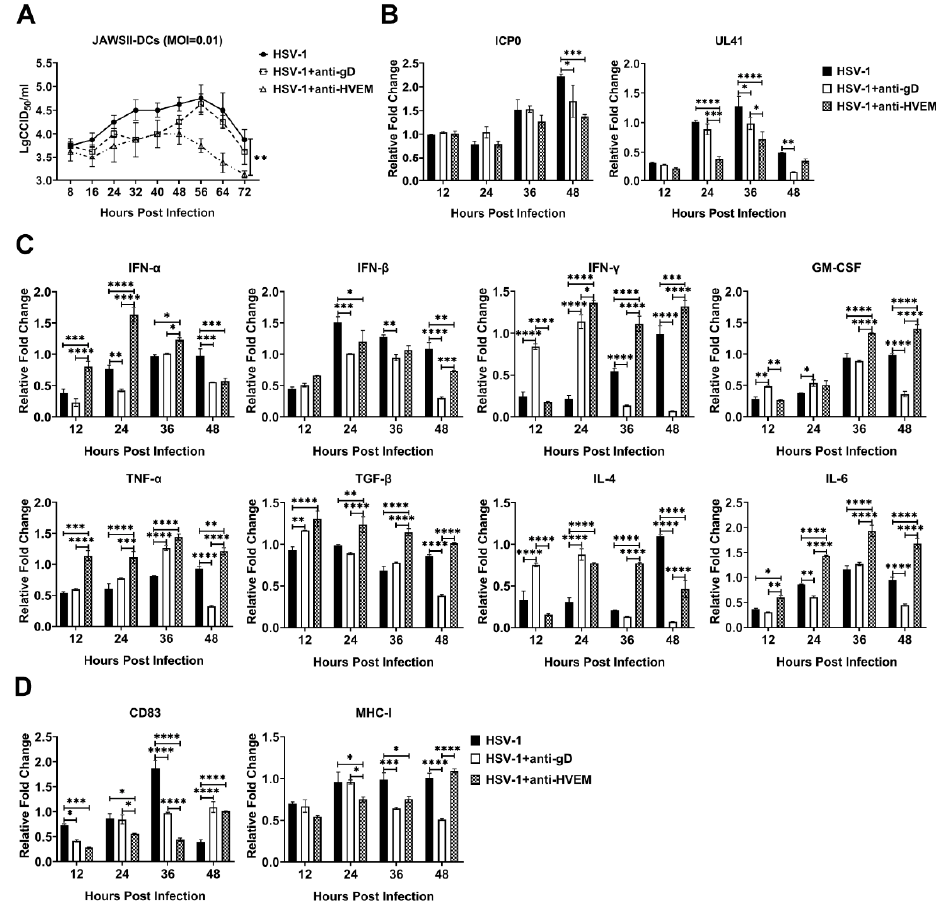
Figure 1. HSV-1 enters dendritic cells via the binding of gD protein to the HVEM receptor and replicates in the cells. The untreated JAWSII dendritic cells were deemed the experimental group, and the two groups of JAWSII dendritic cells treated with anti-gD specific antibody or anti-HVEM specific antibody were deemed the antibody blocking group. ( A ) Growth curves for the McKrae strains from the experimental and antibody blocking groups. ( B ) mRNA expression levels of genes and structural proteins such as ICP0 and UL41 of the McKrae strains in the experimental and antibody blocking groups. ( C ) Transcript levels of the IFN family, GM-CSF, TNF- α , TGF- β , IL-4, and IL-6 in the experimental and antibody blocking groups. ( D ) Expression of the maturation markers CD83 and MHC-I on the dendritic cell surface in the experimental and antibody blocking groups. The relative expression levels of inflammatory cytokines in JAWSII dendritic cells were normalized to their levels in the blank control group by using the comparative Ct (ΔΔCt) method. The data are from three independent experiments that were run in duplicate. Statistical significance was assessed by two-way ANOVA with Holm – Sidak adjustment for multiple comparisons (*, p < 0.05; **, p < 0.01; ***, p < 0.001; ****, p < 0.0001).